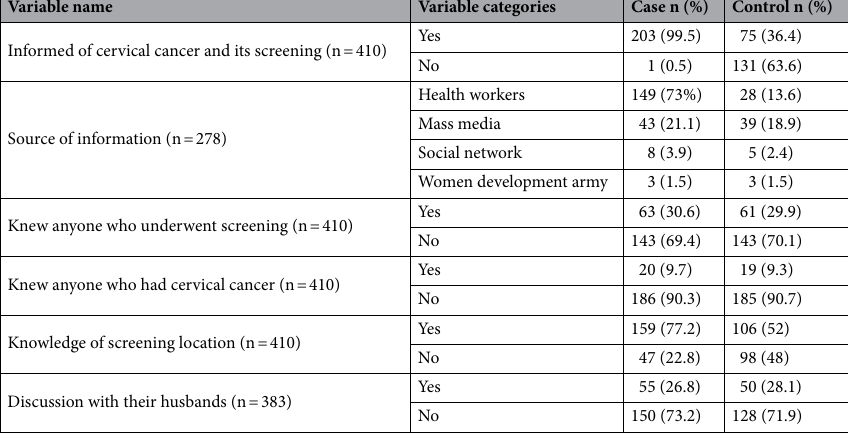
Table 2. Awareness level and information sources among study participants in Hadiya and Kembata Tembaro zones, SNNPRG, Ethiopia, October to November 2021.